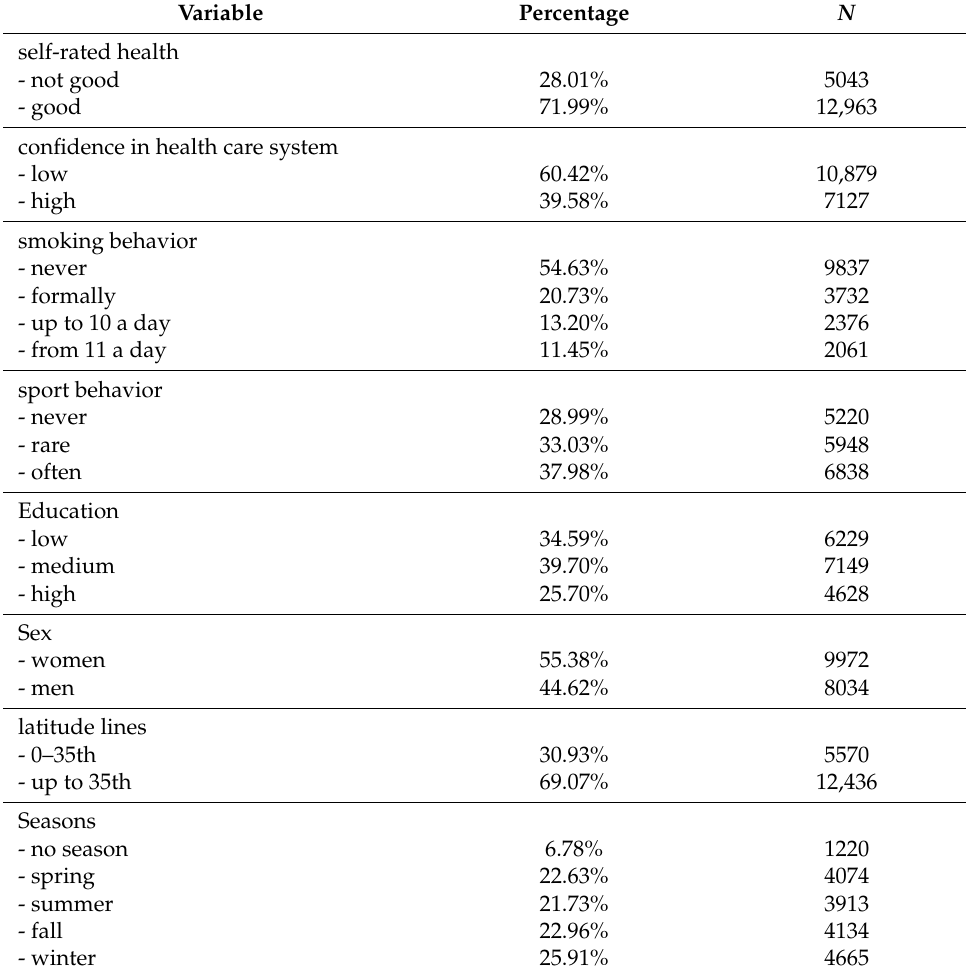
Table 3. Description for categorial variables, N = 18,006.